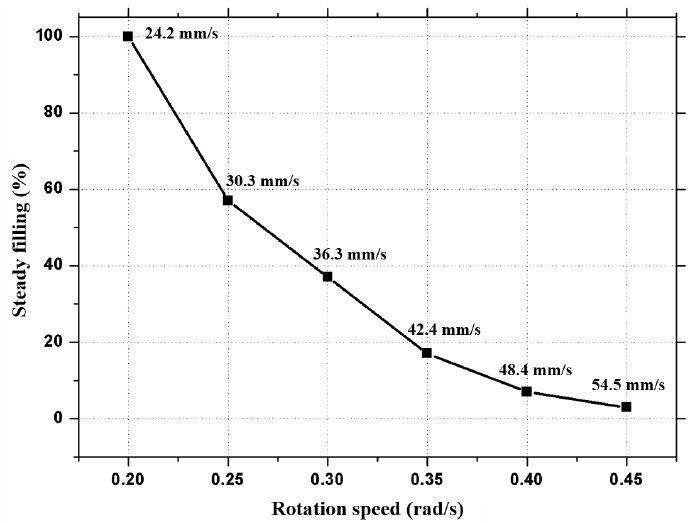
ff erent PET web